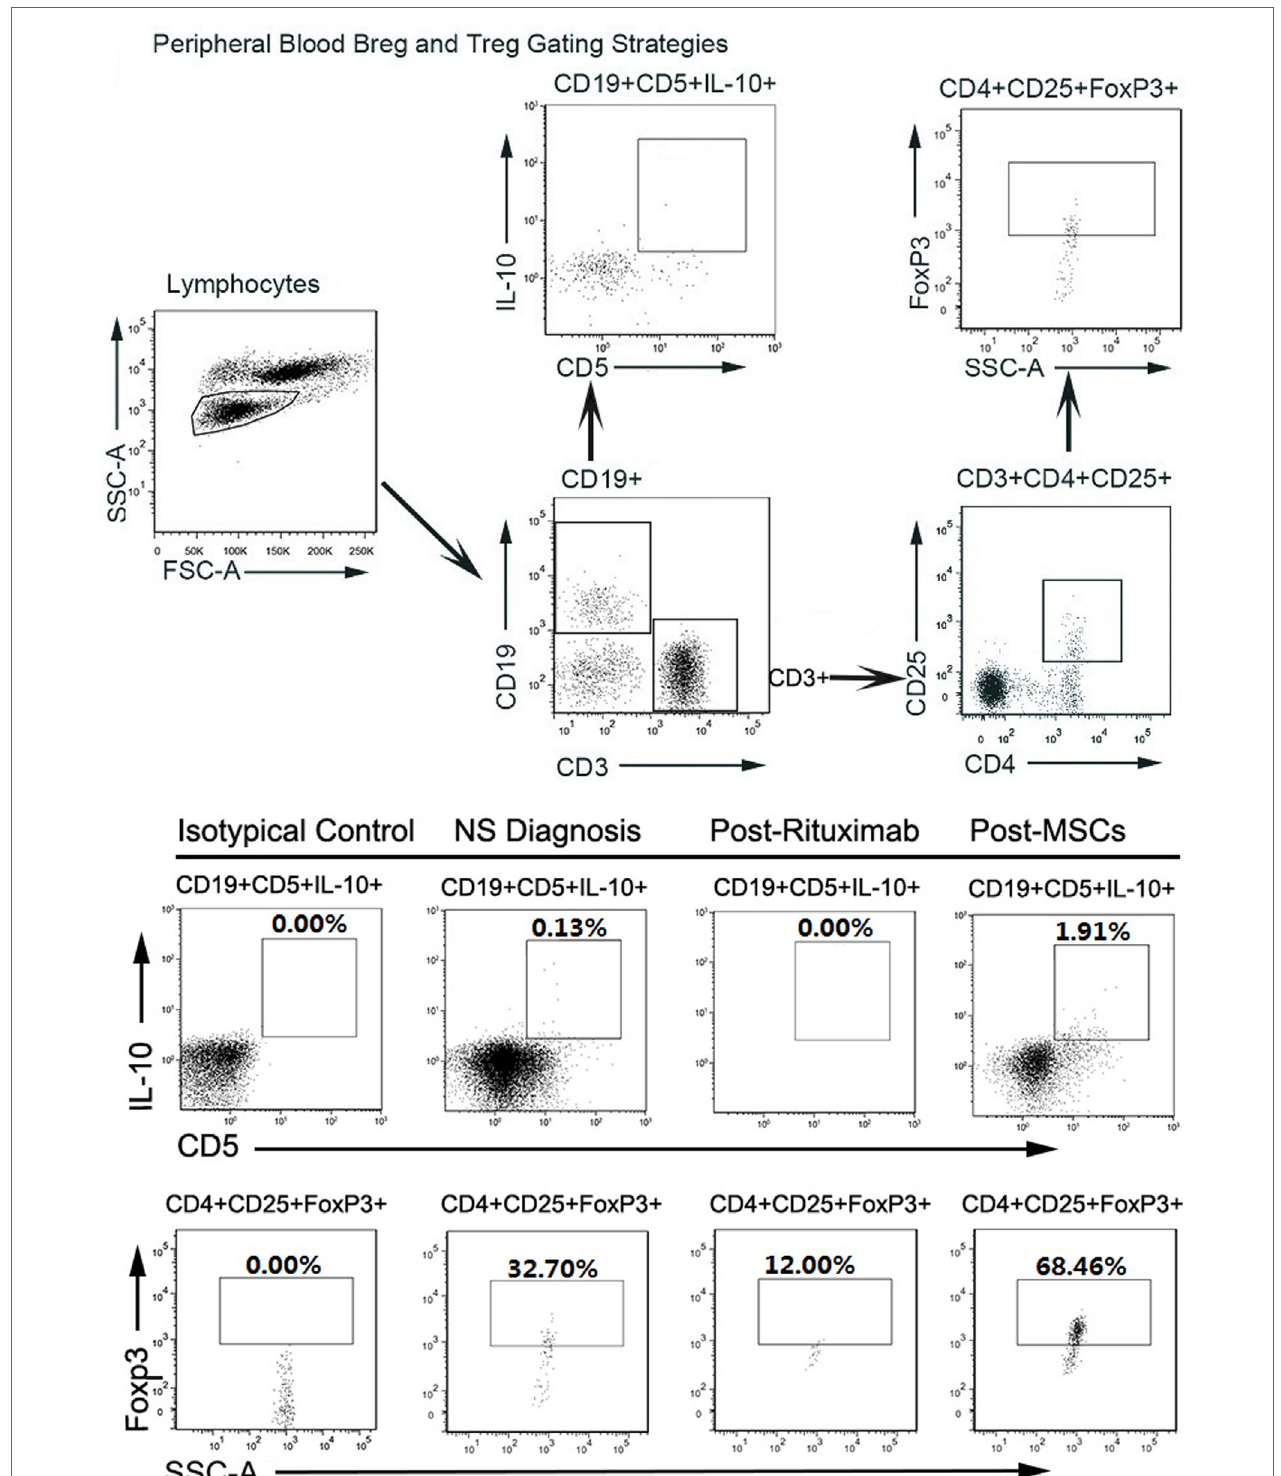
FIgURe 3 | (a) (Above). FACS gating strategy to detect Breg and regulatory T cells (Tregs) in peripheral blood. Circulating regulatory B cells (Bregs) and Tregs were identified from the circulating lymphocyte population as CD19 + CD5 + IL-10 + and CD4 + CD25 + FoxP3 + , respectively, using the gating strategy shown. (B) (Below). FACS results of circulating Bregs and Tregs from Nephrotic syndrome diagnosis, post-rituximab treatment, and post-mesenchymal stem cell (MSC) treatment. FSC-A, forward scatter area; SSC-A, side-scatter